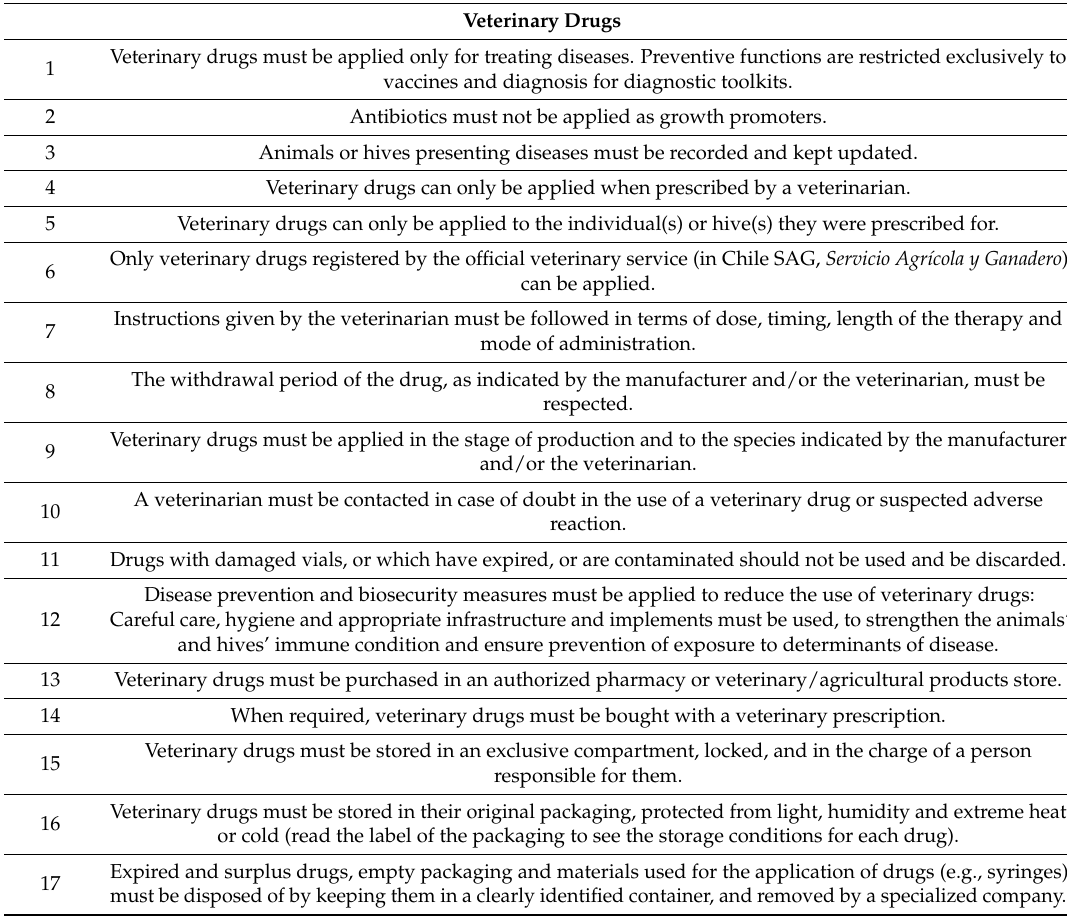
Table A1. Standard good practices (GPs) for the use of veterinary drugs in peasant family farming. Veterinary